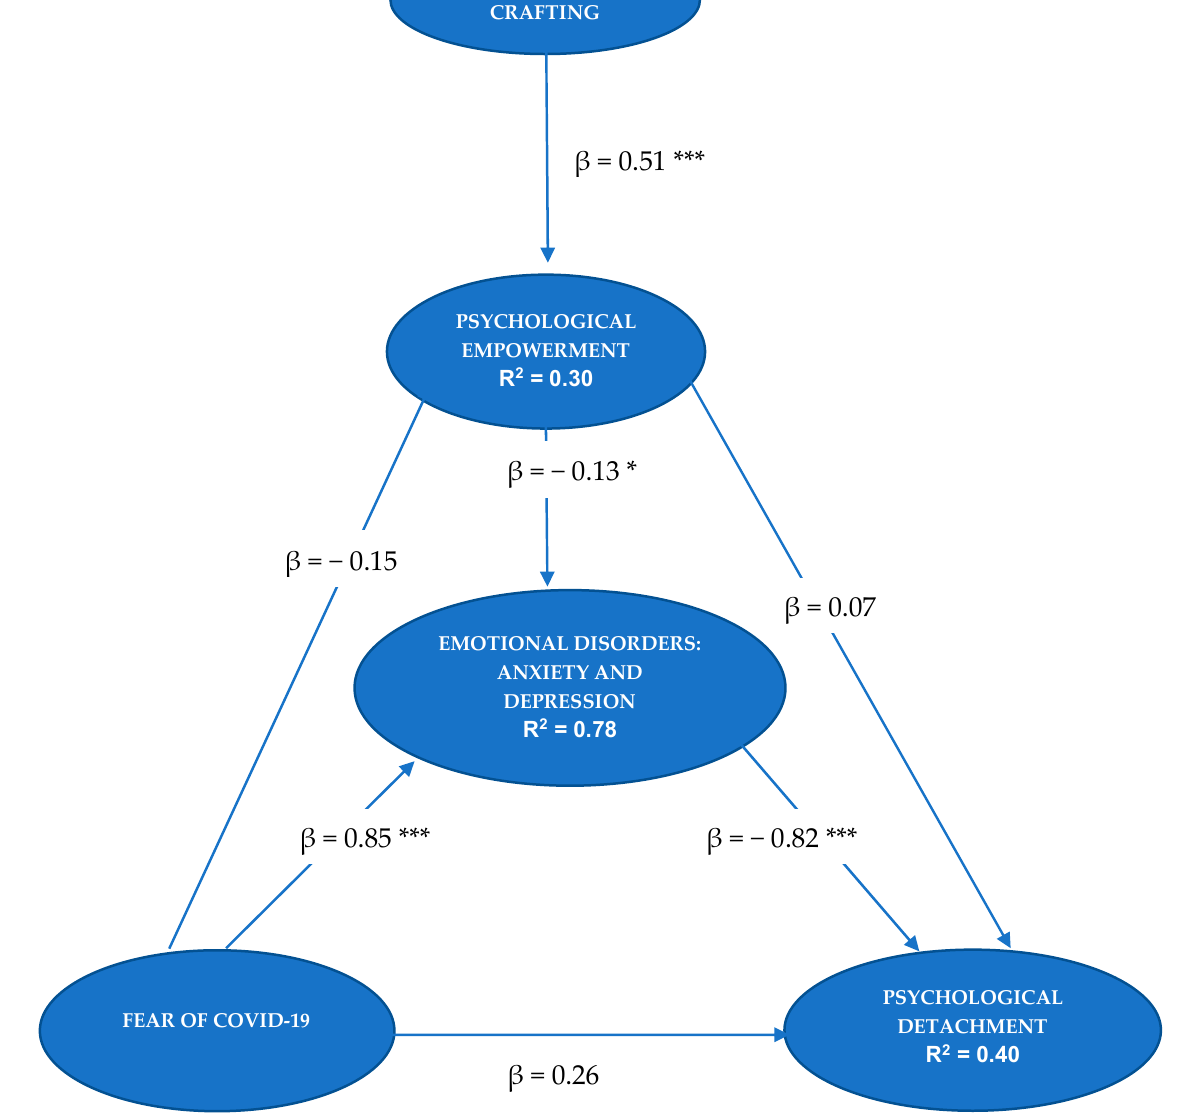
Figure 1. Structural model. * p < 0.05. *** p < 0.001.